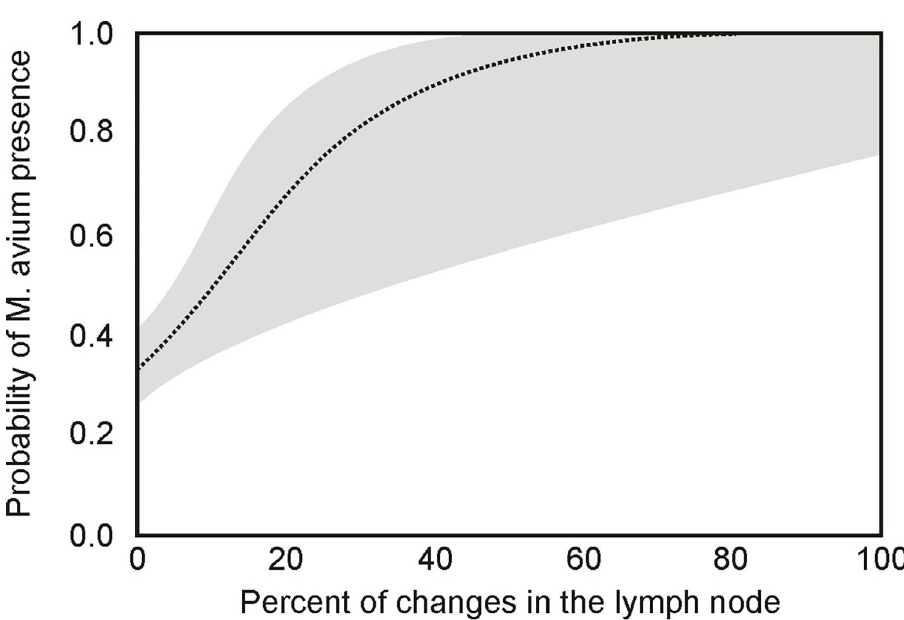
Fig 7. The probability of M . avium presence with 95% confidence intervals (shaded area) depending on the percentage cover of lesions in the lymph node.